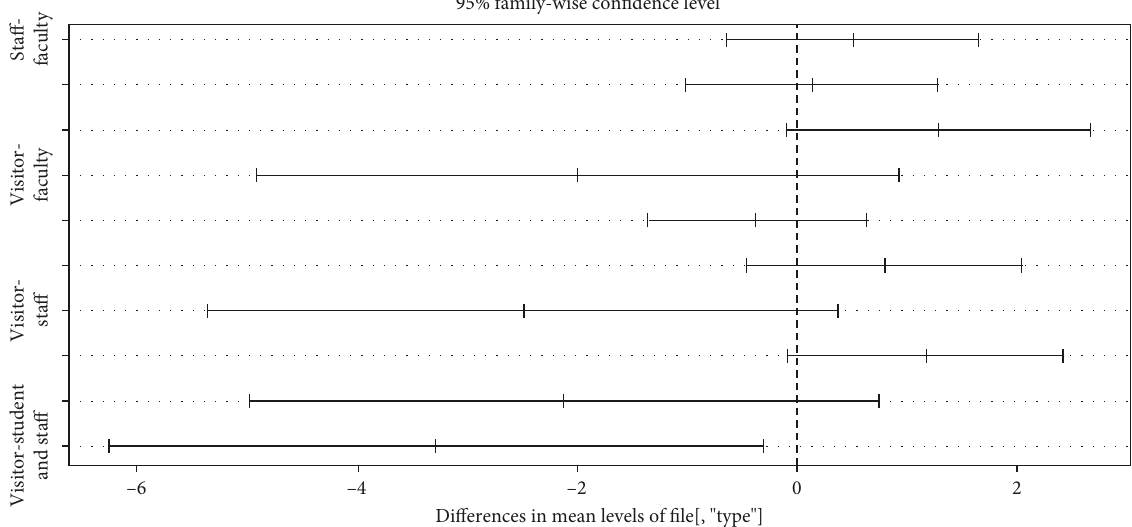
Figure 6: Differences of means between groups